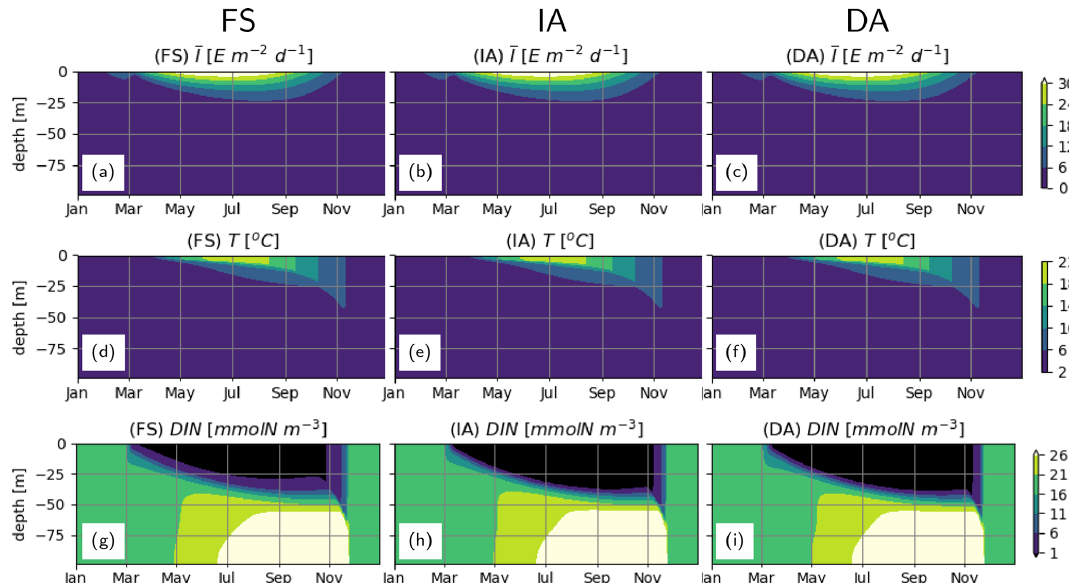
Figure 3. Abiotic environment. (a–c) daytime-averaged photosynthetically active radiation, ¯ I [Em − 2 d − 1 ], (d–f) water temperature T [ ◦ C] and (g–i) DIN [mmolNm − 3 ], as simulated by the FS (a, d, g) ; IA (b, e, h) and DA (c, f, i)